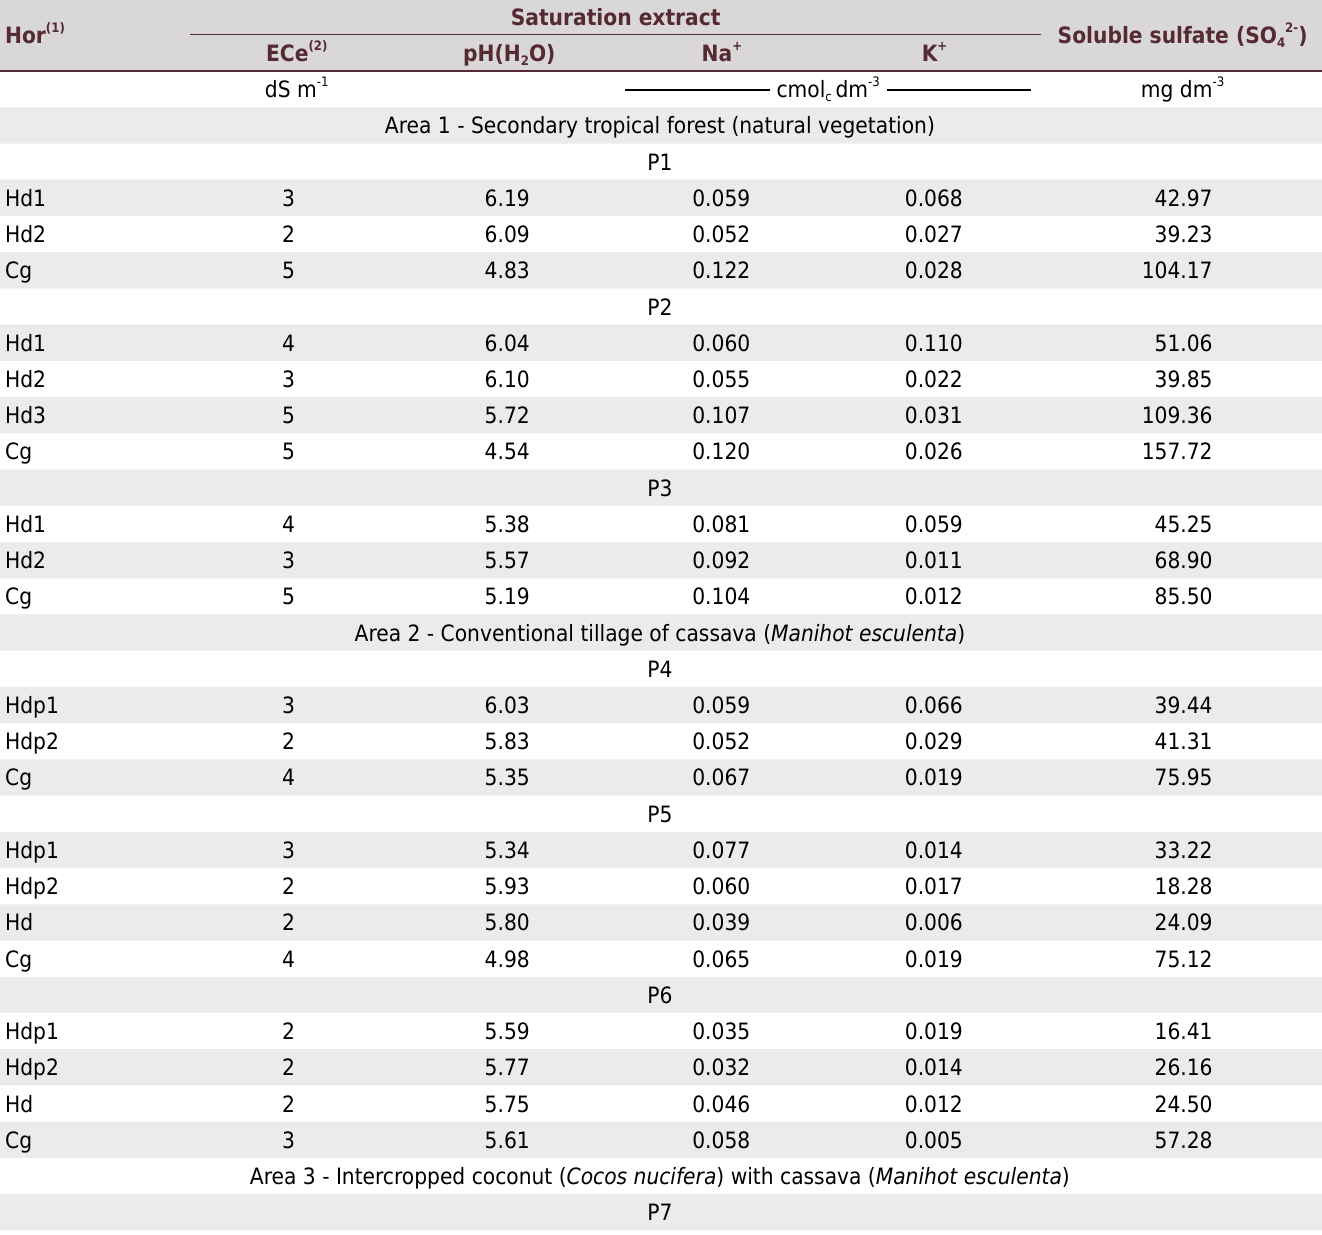
Table 4. Electrical conductivity, pH, Na, K, and soluble sulfate in the saturated soil-paste extract of the studied Histosol profiles Hor